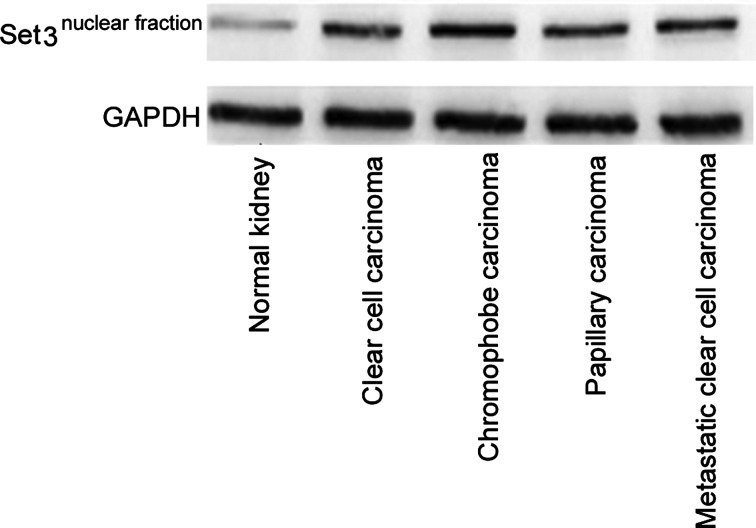
Increased expression of SET domain-containing proteins in nuclear fractions of different classes of renal cell carcinoma in comparison with control renal tissuesRepresentative western blots are shown. Nuclear fractions were eluted by differential centrifugation. Quantitative estimates showed highly significant difference between the means (P<0.0001, ANOVA, Tukey's HSD post-hoc test).